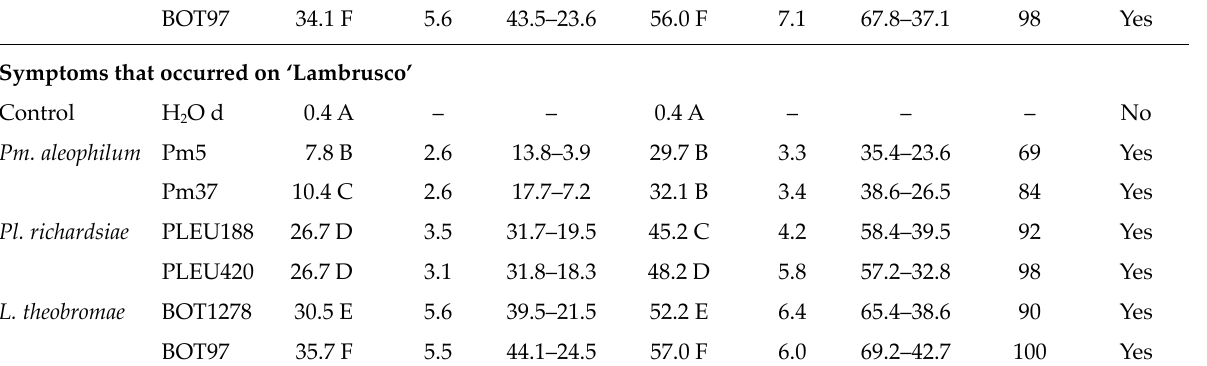
Fungal species Isolate